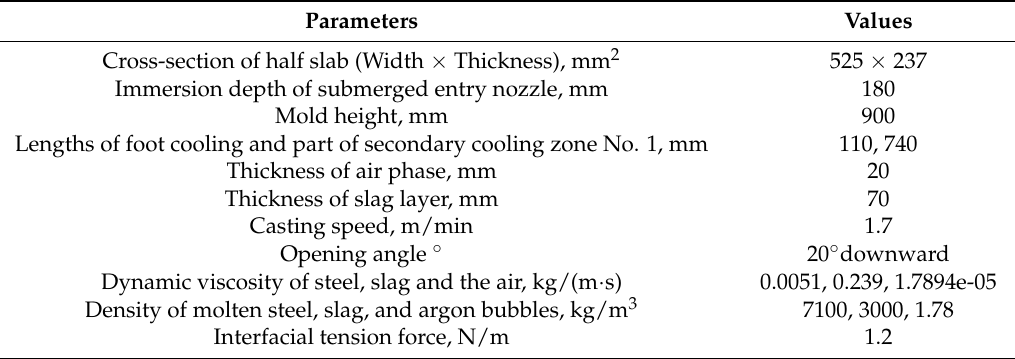
Figure 1. Geometry model and boundary conditions. Table 1. Geometry and material properties for simulation.